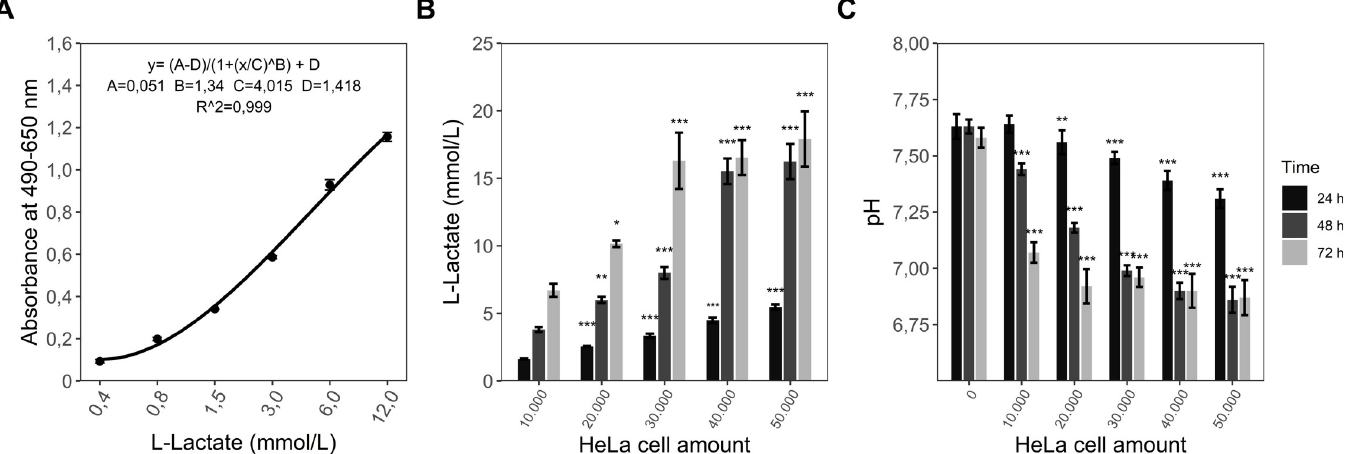
Fig 2. L-Lactate determination in HeLa cell culture. (A) Example of a standard curve and the equation for quantification of L-lactate in the custom assay. Different cell amounts of HeLa cells were seeded in 96-well plate format and cultured in RPMI Medium. After 24h, 48h and 72h (B) L-Lactate concentration and (C) pH were measured using the described protocols. The data represents the mean ± sd of two independent experiments. (A) � p < 0,05 compared to 10.000 cells, �� p < 0,01 compared to 10.000 cells and ��� p < 0,001 compared to 10.000 cells. (B) � p < 0,05 compared to RPMI Medium, �� p < 0,01 compared to RPMI Medium and ��� p < 0,001 compared to RPMI